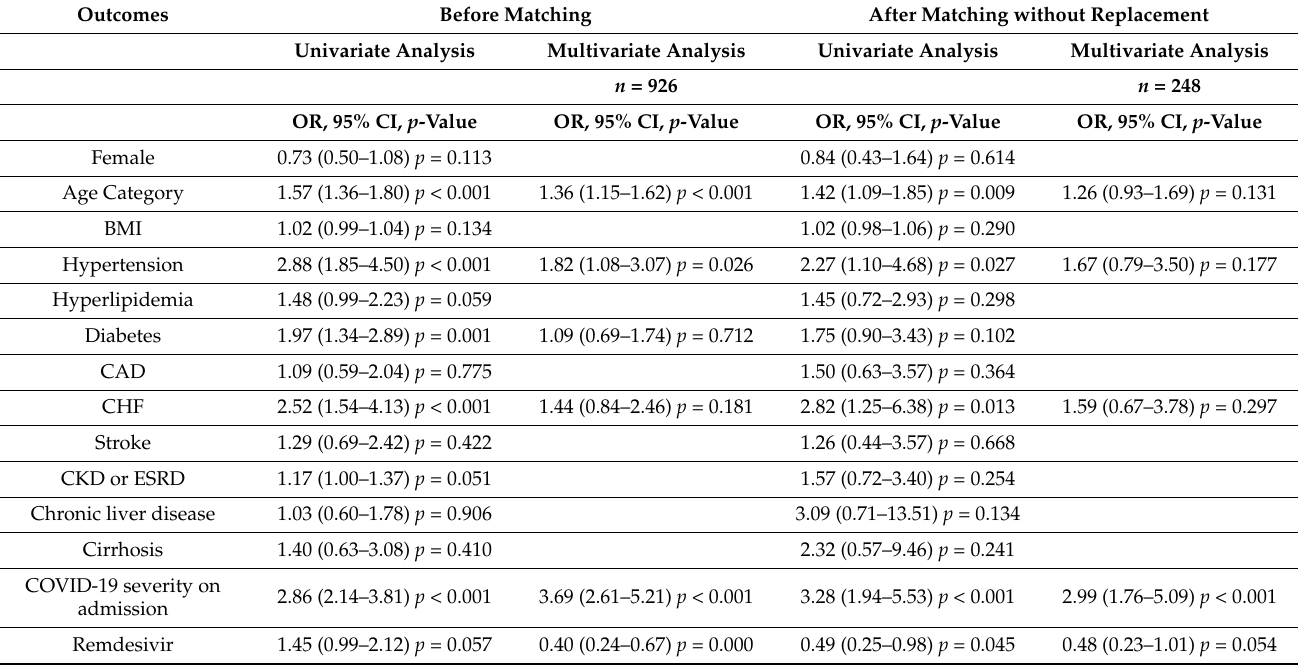
Table 5. Logistic Regression Analysis for Acute Kidney